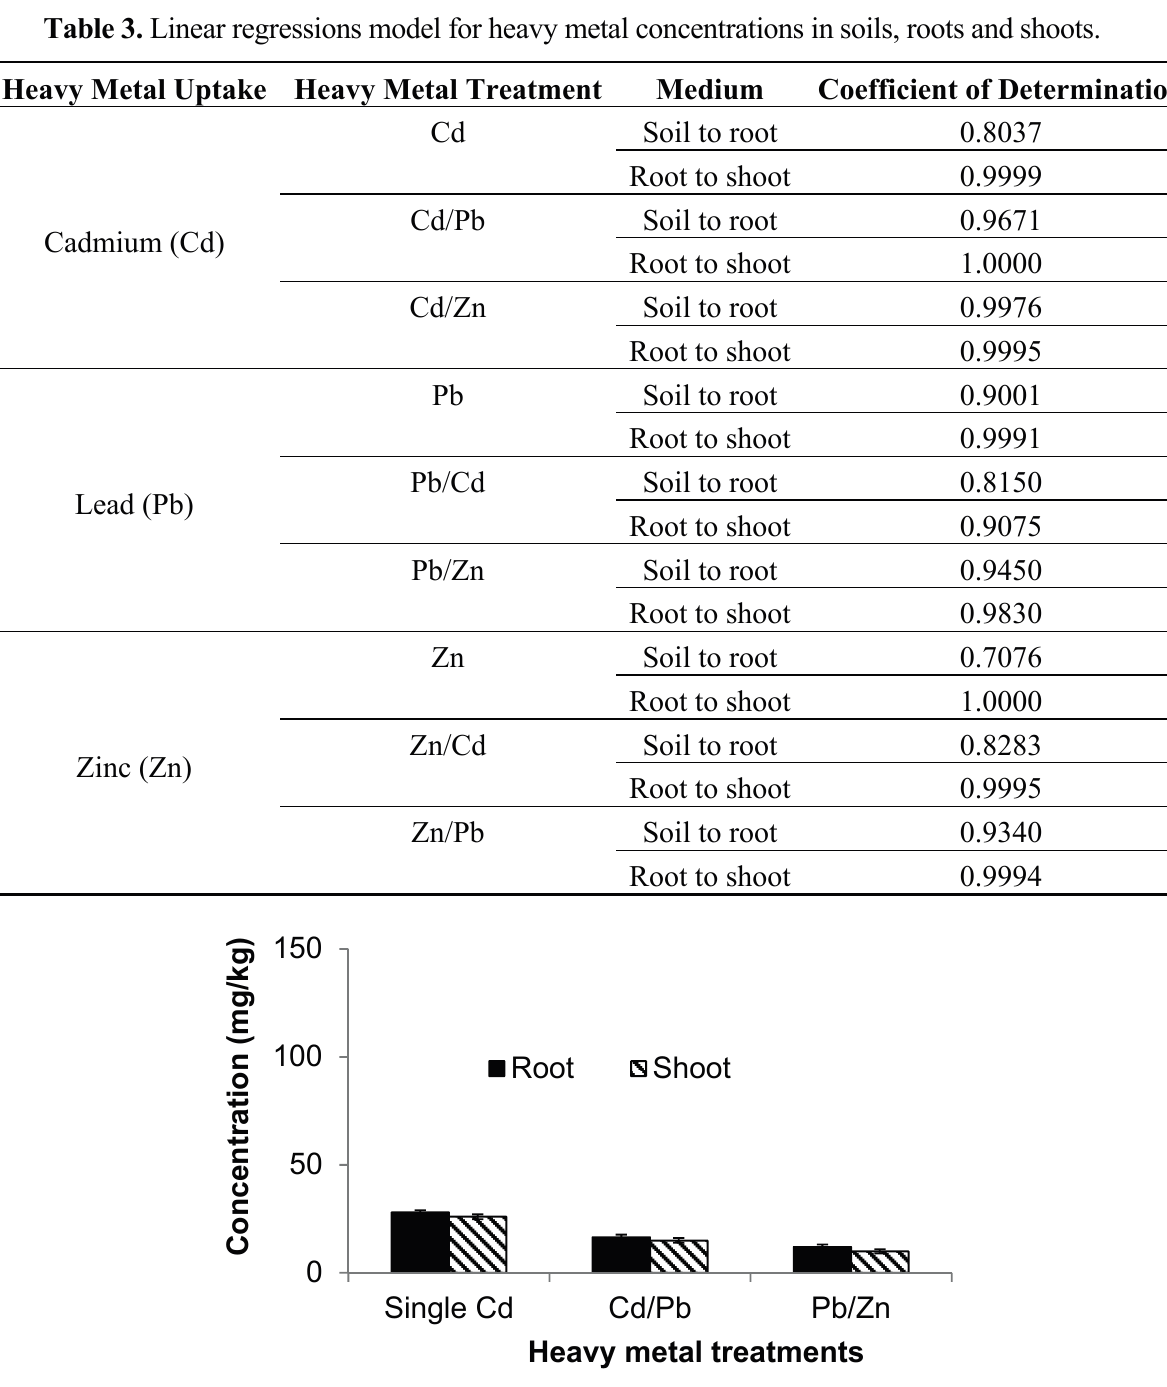
Figure 3. Comparison of cadmium (Cd) uptake subject to different